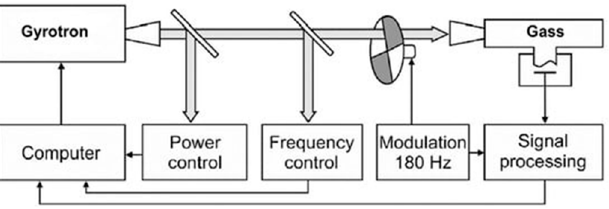
Figure 2. Schematic of a gyrotron-based radio-acoustic detection (RAD)